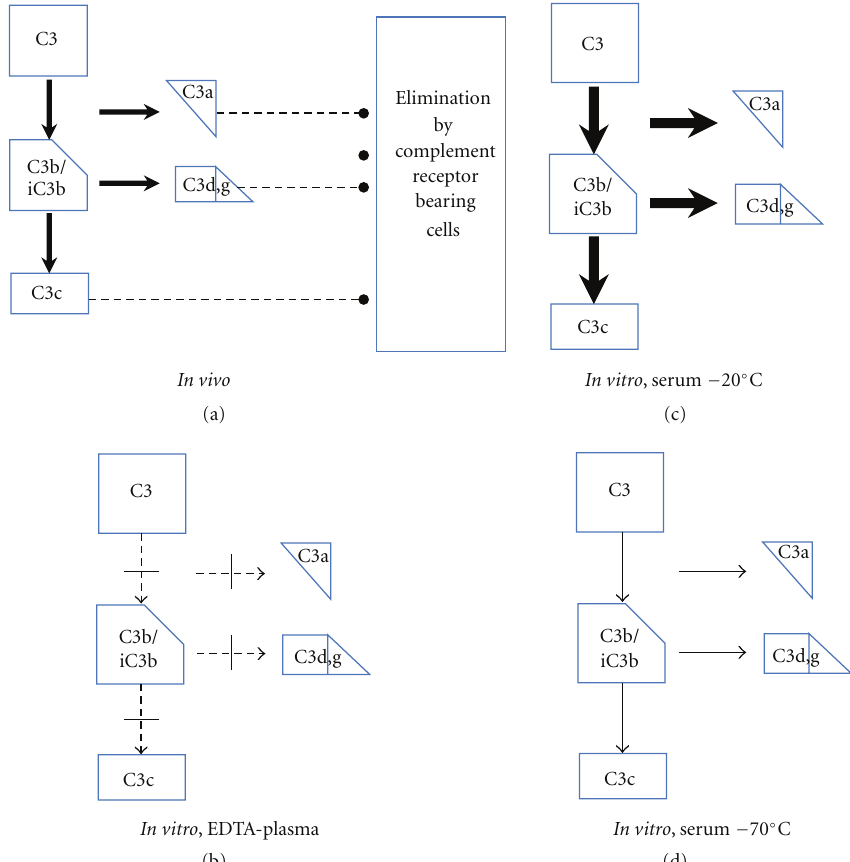
Figure 2: Activation and consumption of complement in vivo and in vitro . In vivo , complement is activated, and C3 gives rise to the activation products C3a, C3b/iC3b, C3d,g, and C3c (indicated by arrows). In vivo , a fraction of these complement products are bound to and eliminated by di ff erent complement receptor-bearing cells in contact with plasma (a). When blood is drawn in the presence of EDTA, all further complement activation is inhibited (b). The complement system is active in serum and may be activated to a substantial degree in vitro in maltreated samples (c), but it can be kept essentially intact in properly handled samples (d). The thickness of the arrows in each panel indicates the degree of C3